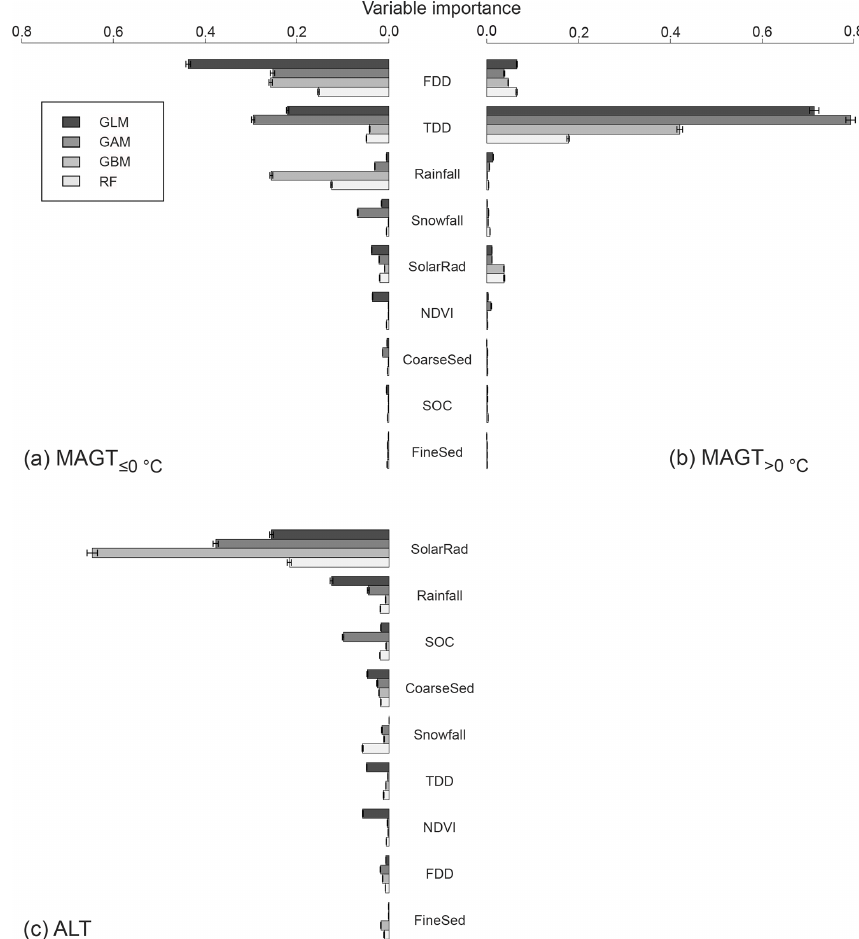
Figure 3. Variable importance values in MAGT ≤ 0 ◦ C (mean annual ground temperature less than or equal to 0 ◦ C) (a) and MAGT > 0 ◦ C (mean annual ground temperature greater than 0 ◦ C) (b) datasets arranged in the descending order of the four-model average in MAGT ≤ 0 ◦ C conditions, and for ALT (active-layer thickness) (c) , arranged likewise based on ALT results. The whiskers depict 95% confidence intervals (over 100 bootstrapping rounds). GLM: generalized linear modelling; GAM: generalized additive modelling; GBM: generalized boosting method; RF: random forest. See Sect. 2.2 for predictor